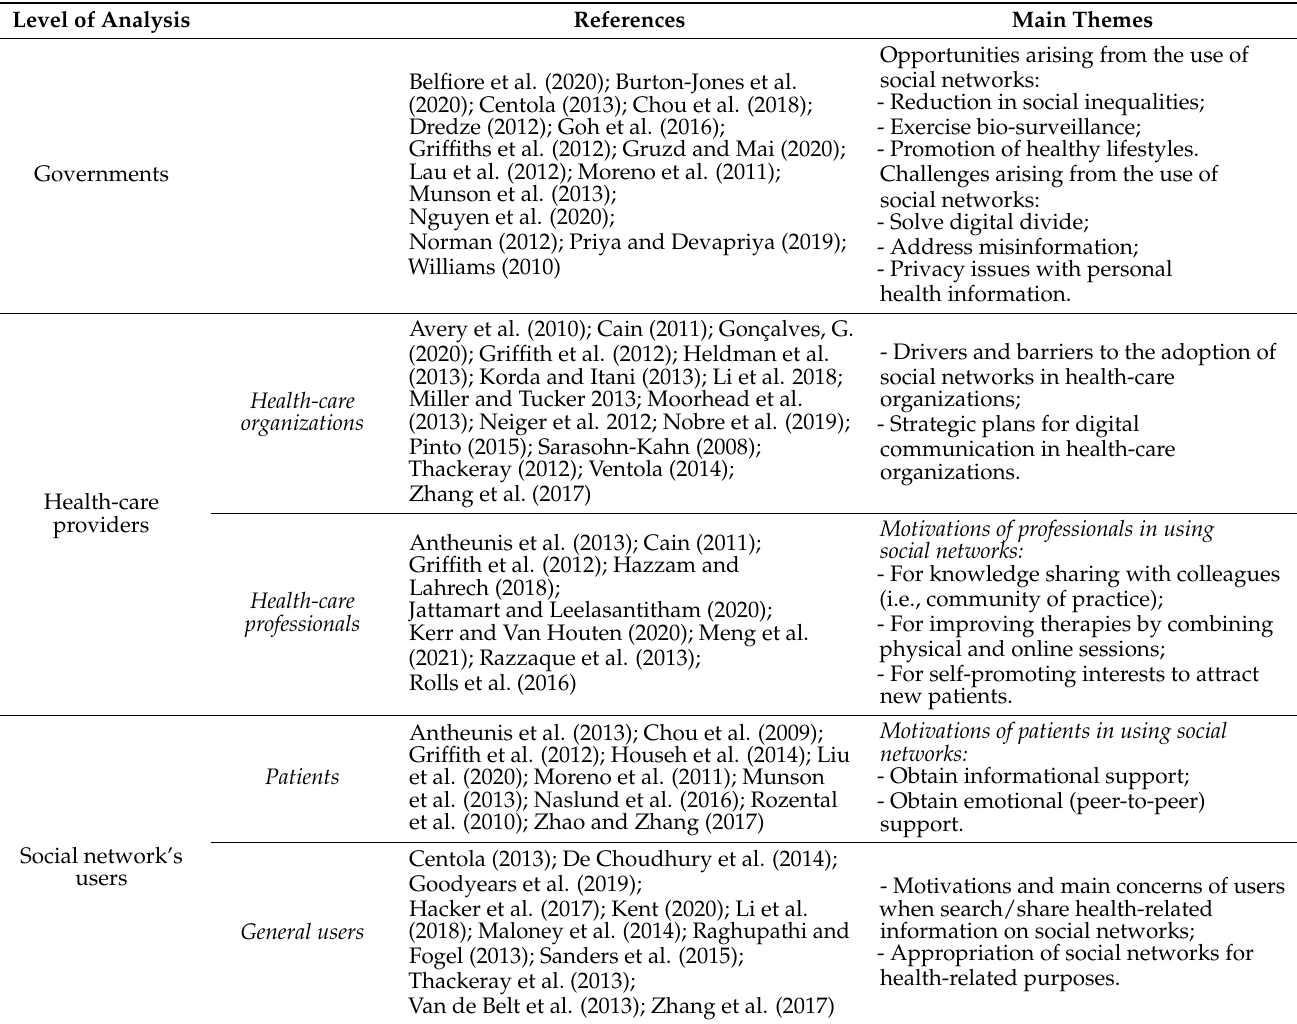
Table 1. Distribution of documents for level of